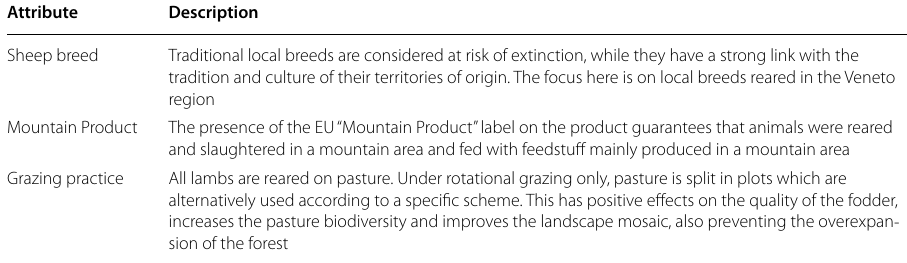
Table 8 Description of the attributes provided to respondents before the choice experiment Attribute Description